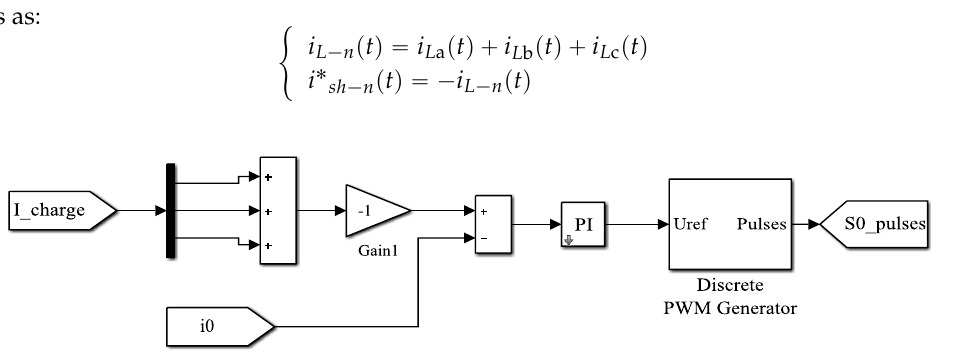
Figure 6. Voltage source inverter ( V SI ) forth leg controller to suppress the source-end zero current.